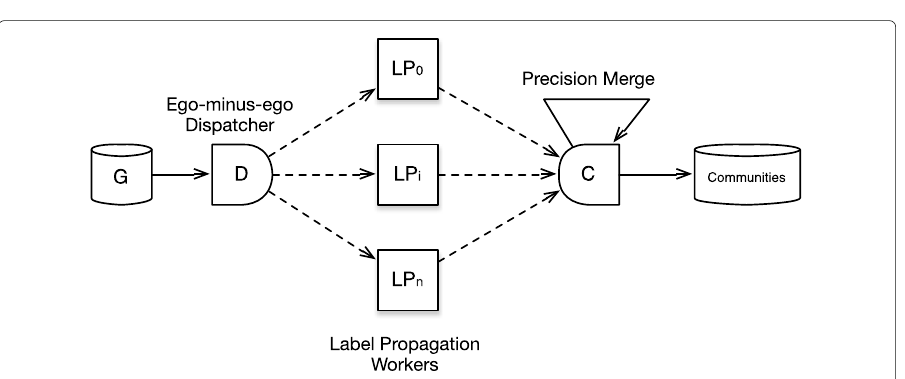
Fig. 3 A NGEL parallelization schema. The graph G is decomposed in | V | ego-minus-ego network by